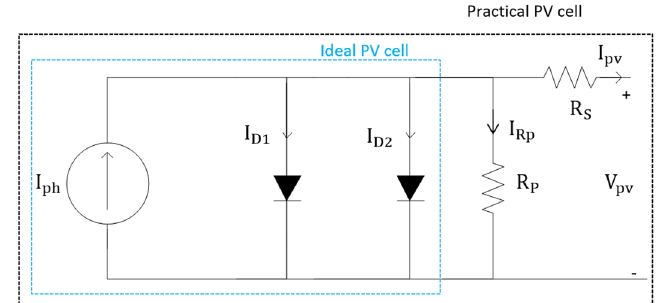
Figure 2. Double-diode PV model